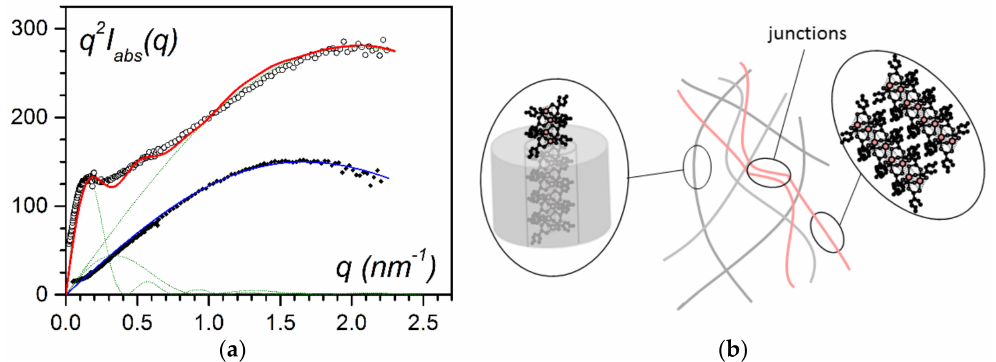
Figure 6. ( a ) Small-angle neutron scattering data for IPS/CuS8/trans-decahydronaphthalene gels: in all cases C iPS = 0.04 g/cm 3 , for C CuS8 = 0.038 g/cm 3 , for C CuS8 = 0.055 g/cm 3 . The solid lines (cid:35) (red and blue) fit with theoretical models (see text for details) [17,20]. ( b ) Sketch of the molecular structures for C CuS8 = 0.055 g/cm 3 : encapsulated fibrils, free-associated filaments and their junctions. The encapsulated fibrils represent 99% of the